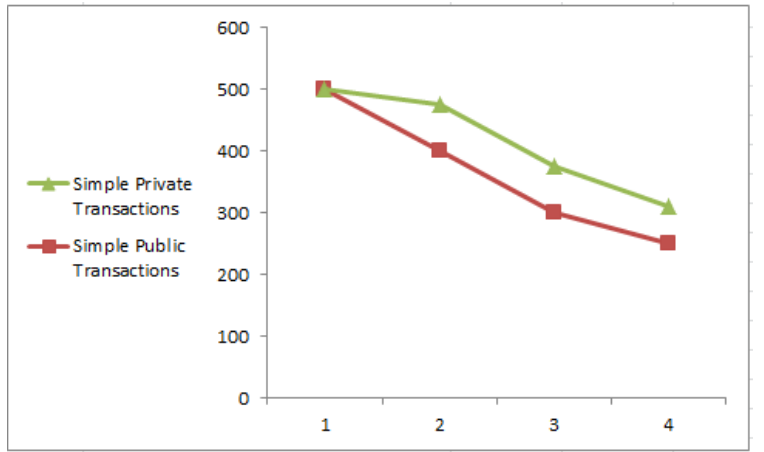
Figure 21. Effects of endorsement policy